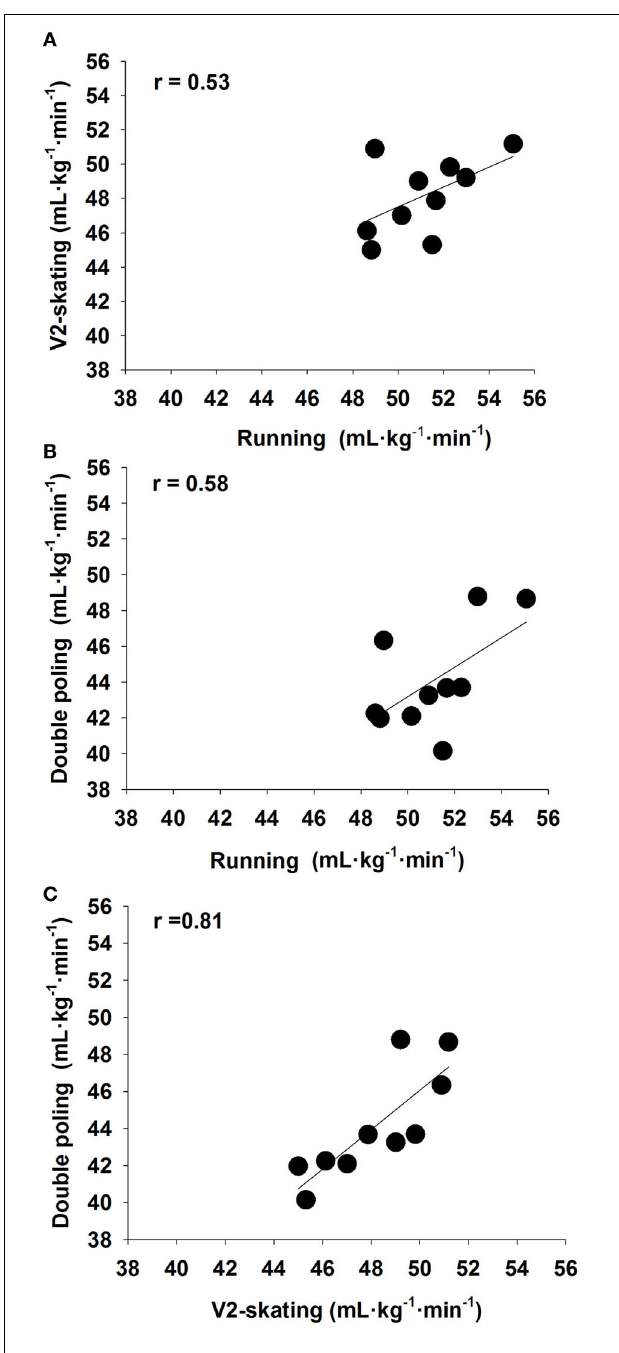
FIGURE 2 | Relationinexerciseeconomy(oxygencostatsteadystate)in runningvs.V2-skating(A),runningvs.doublepoling(B),andV2-skating vs. doublepoling (C)inten malewell-trained cross-countryskiers. Correlationvalues ( r )wereobtained usingPearson’s Product Moment